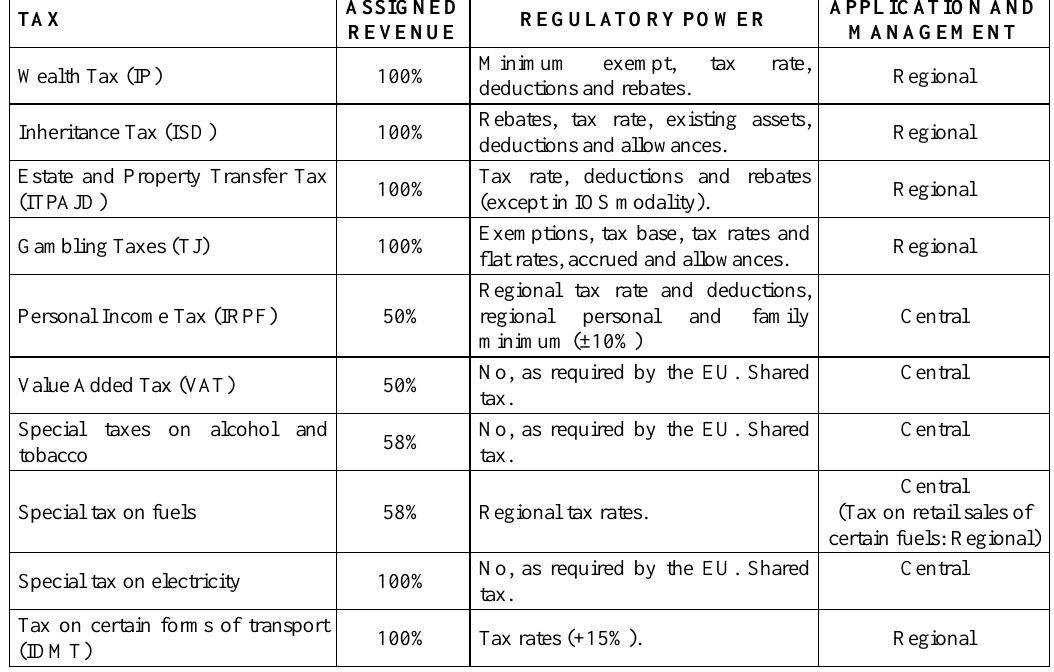
Table 1 : Taxes assigned to the Spanish regions, regulatory and management powers*